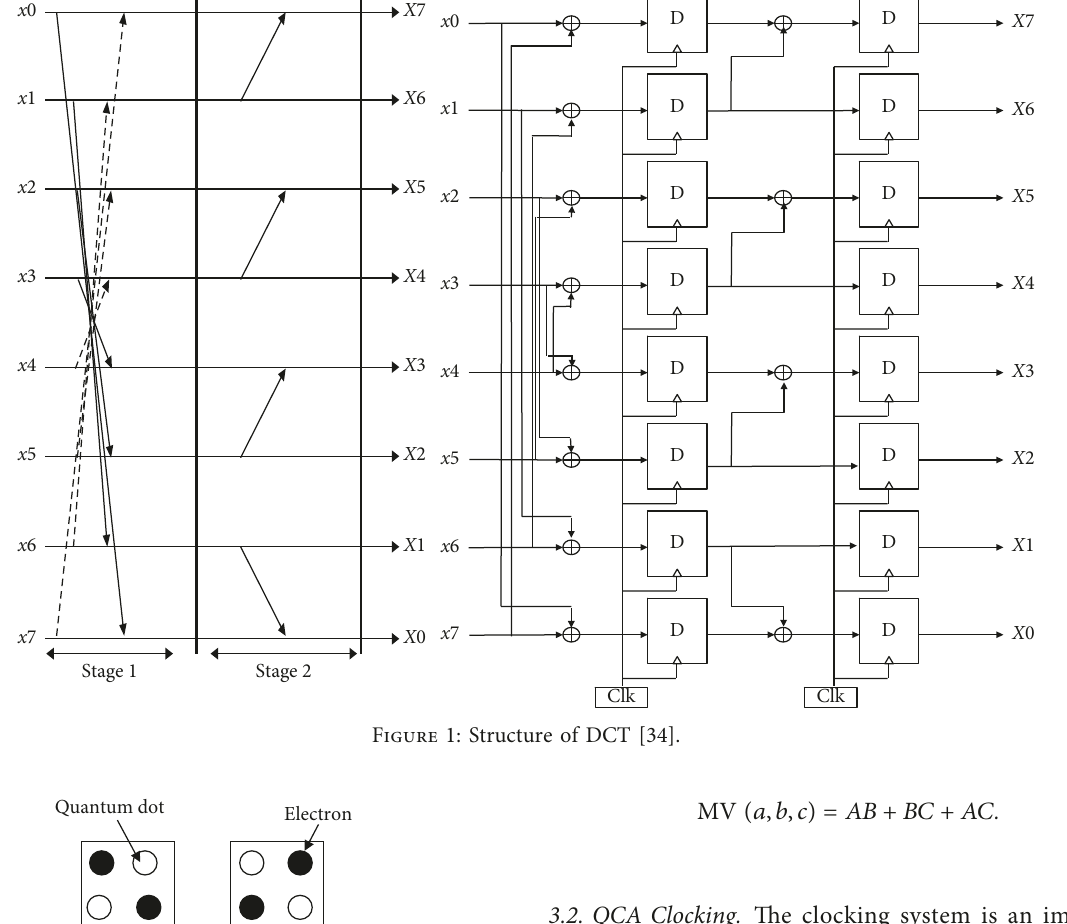
Figure 2: Two different polarizations of the quantum-dot cell.